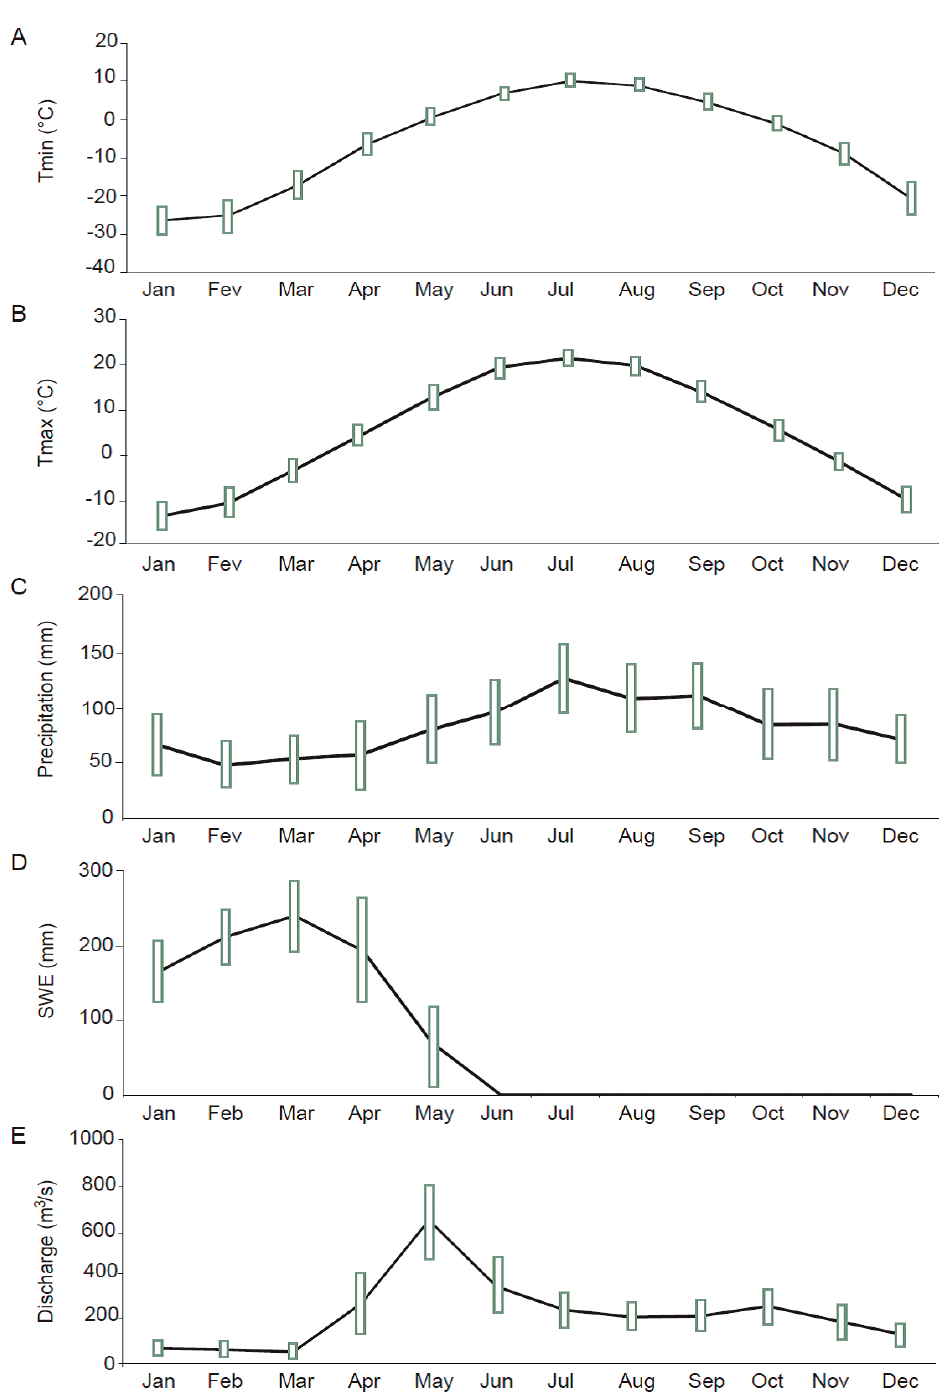
Figure 2. Mean monthly climatology at the Mistassibi Basin: ( A ) minimal temperature, ( B ) maximal temperature, ( C ) precipitation and ( D ) snow water equivalent (SWE); and ( E ) monthly discharge at the Mistassibi station over 1961–2000. The vertical bars represent the maximum and minimum values for each meteorological